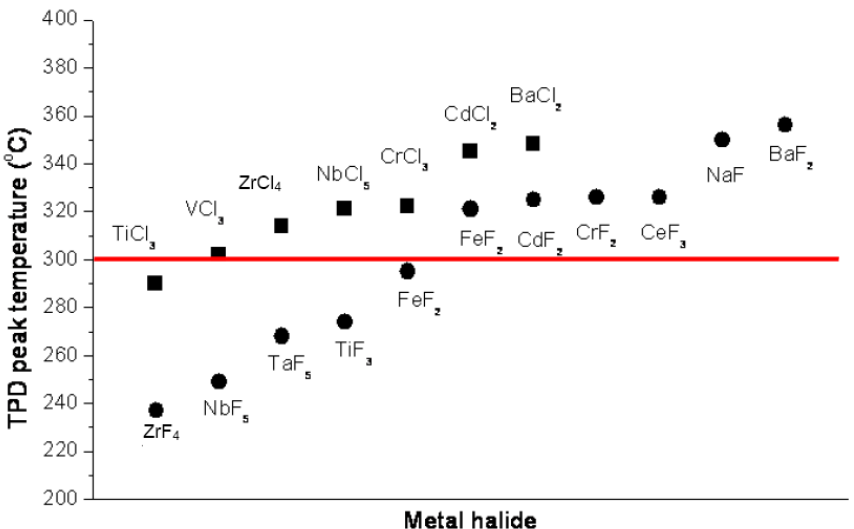
Figure 17. Dehydrogenation TPD peak temperature of ball milled MgH 7 wt.% of various halides as a function of the type of a halide additive. The horizontal line shows the limit of 300 °C for TPD peak temperature. Adapted from